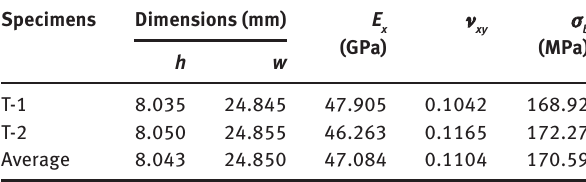
Table 5: Dimensions and test results of